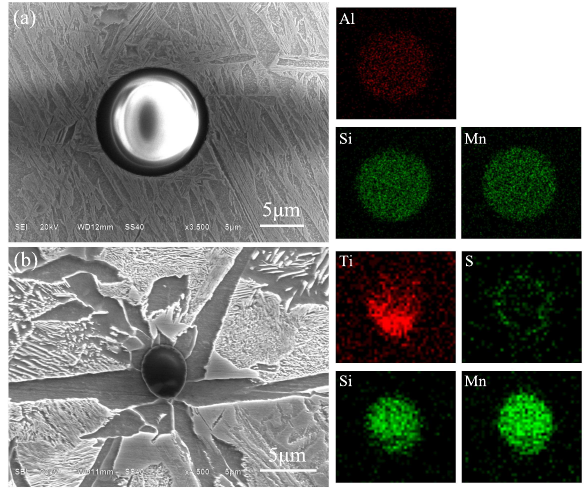
Figure 5: SEM micrograph and EDS mapping images for typical oxide after etching (a) For Non-treated sample (b) For EAM-treated